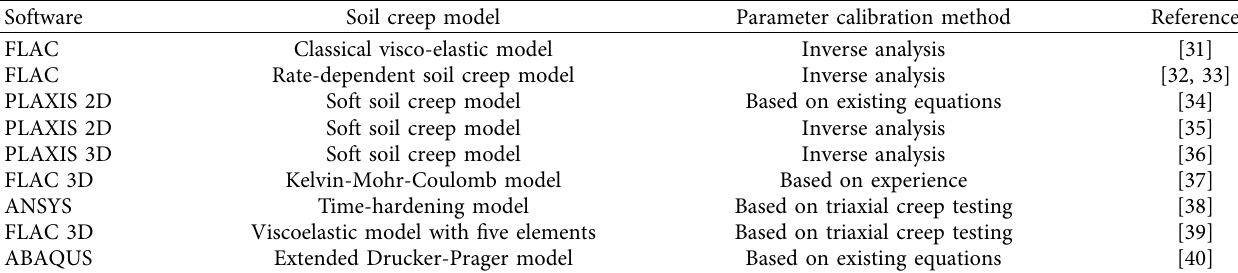
Table 1: Summary of typical studies using numerical simulation